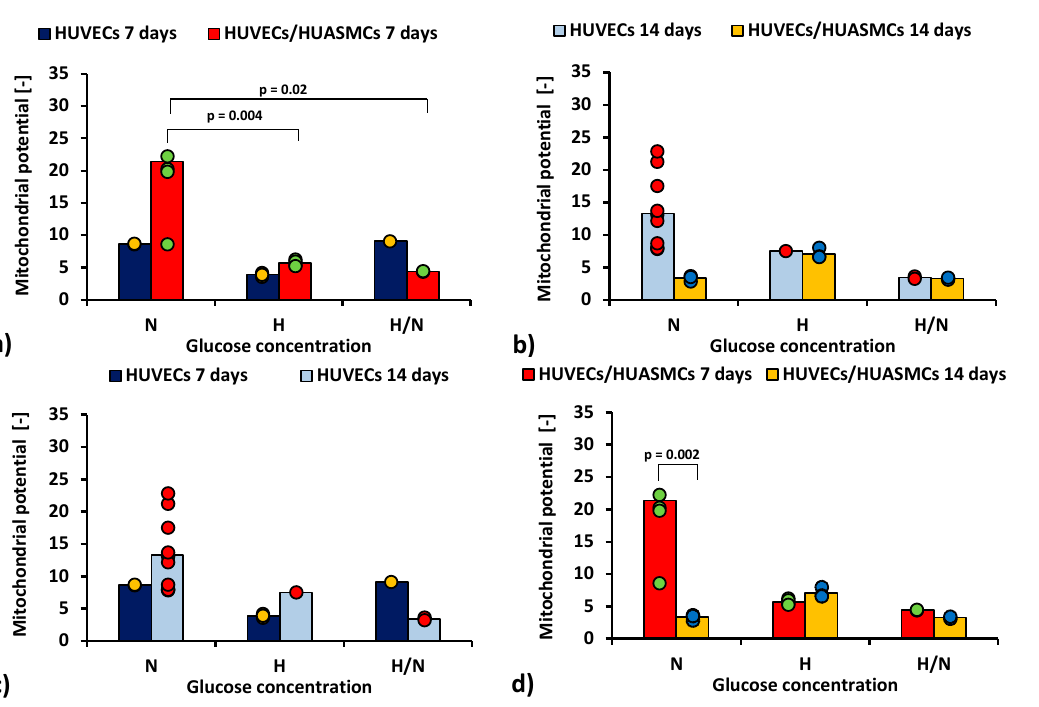
Figure 3. Mitochondrial membrane potential of HUVECs: after 7 days of culturing without HUASMCs or co-culturing with HUASMCs ( a ); after 14 days of culturing without HUASMCs or co-culturing with HUASMCs ( b ); after 7 and 14 days of culturing without HUASMCs ( c ); after 7 and 14 days of co-culturing with HUASMCs ( d ); in normal (N), high (H), or variable (H/N) glucose concentration on PSU flat membranes covered with fibronectin. The data are presented as scatter plot (yellow, green, red and blue dots) with corresponding bar graphs.